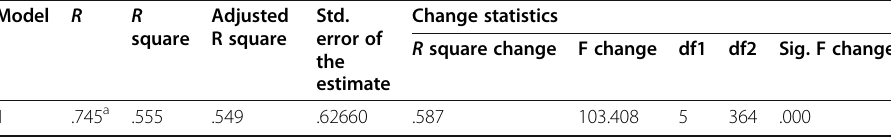
Table 6 Model summary Model